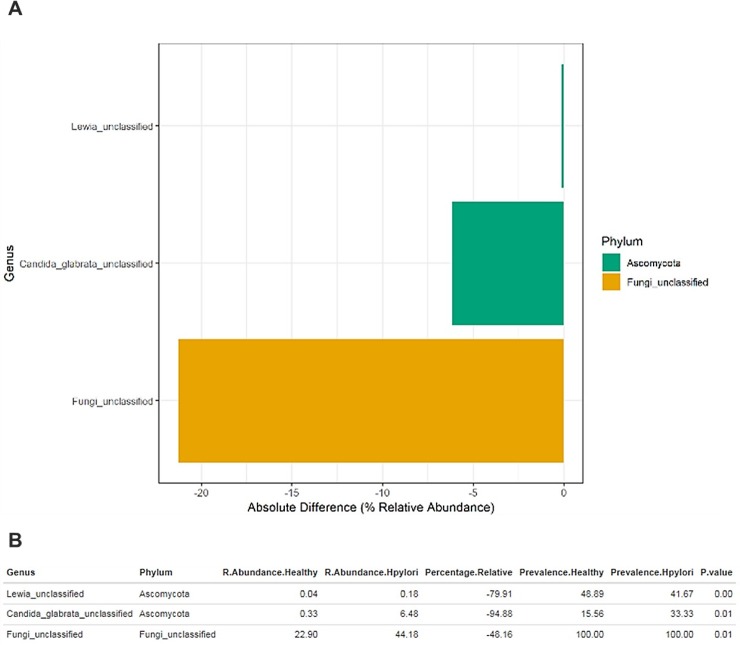
Exploration of the fungal diversity in H. pylori infected and healthy subjects.(A) The bar plot reports only genera with an absolute percentage difference between H. pylori infected and healthy averages >0.1% and a p-value < 0.05, evaluated by means of ANOVA statistical analysis. (B) The table indicates the fungal genera, the relative abundance and the prevalence of each group, the relative percentage difference and the p-value.